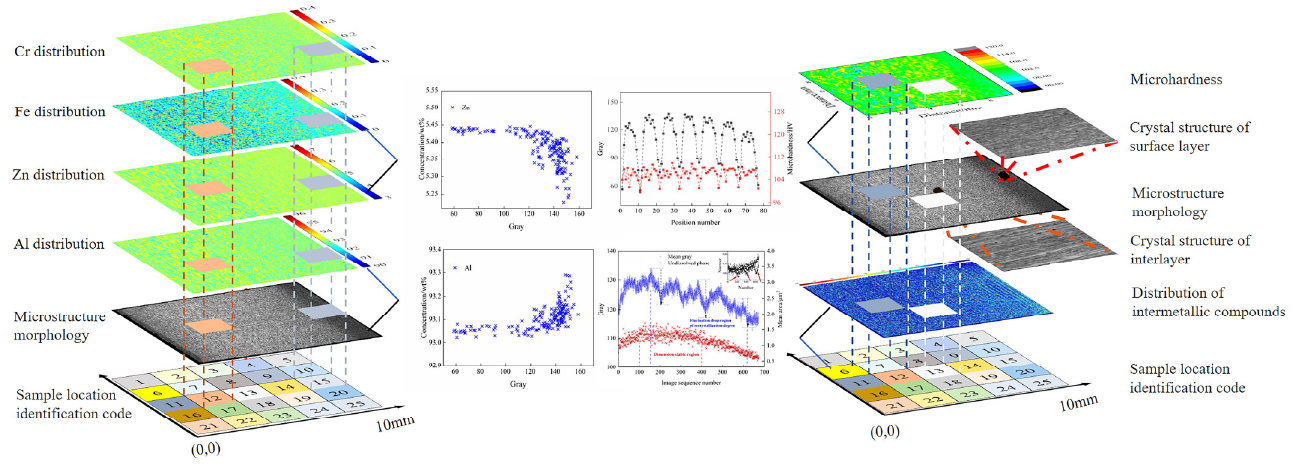
Figure 15. Spatial-mapping model of composition–structure–hardness in 7B05 aluminum alloy.